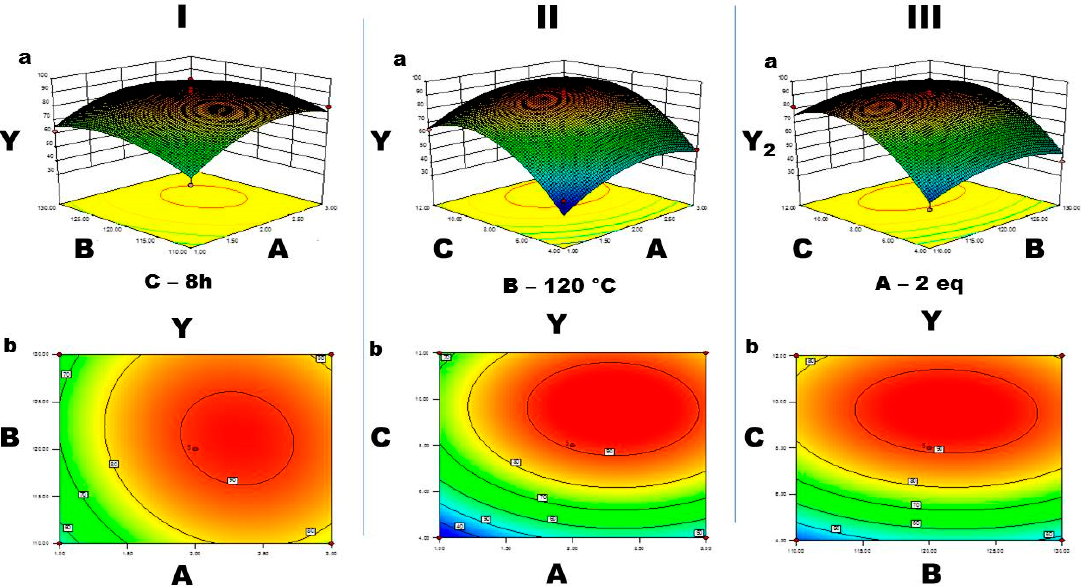
Figure 3. Contour plots for parameters combined yield for reaction conditions without metal. ( I ) Effect of A and B; ( II ) Effect of A and C; ( III ) Effect of B and C.